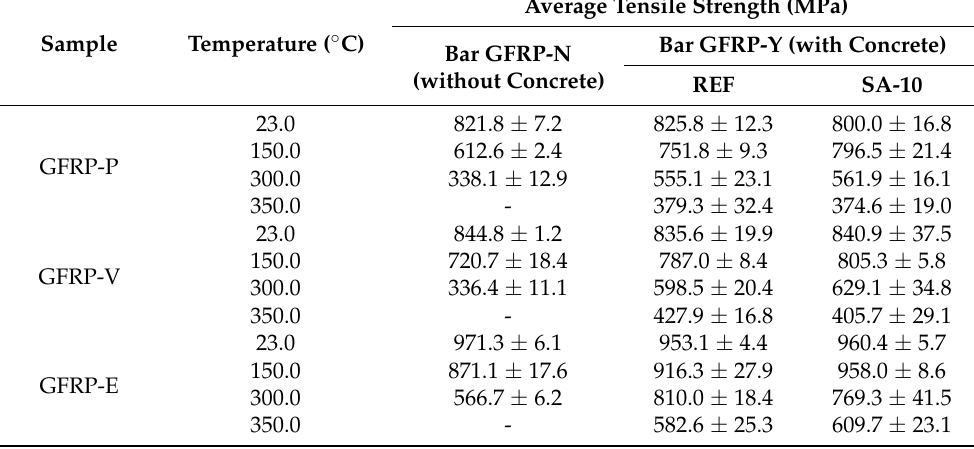
Table 5. Tensile test results GFRP bars without and with covered concrete (REF and SA-10) submitted at elevated